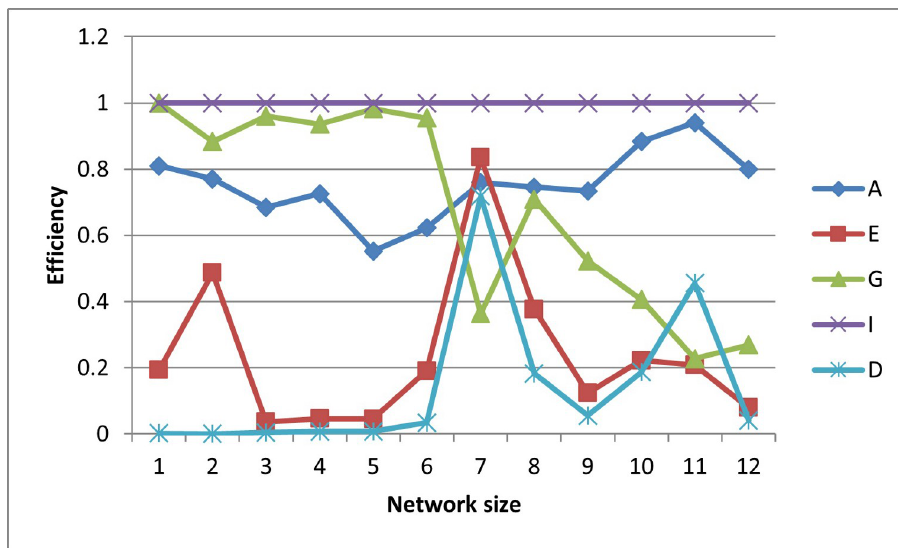
Fig 20. I-efficiencies of various optimal designs for the second case study.